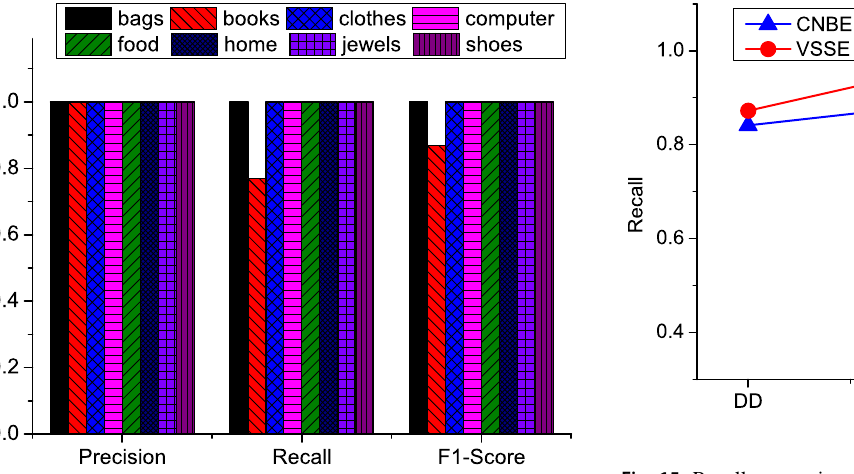
Fig. 12 Extraction performance on http://www.yhd.com